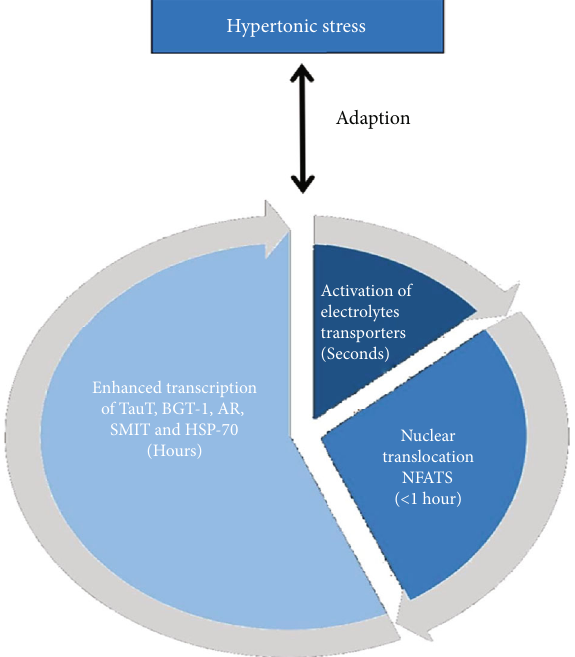
Figure 2: Cell adaption to hypertonic stress. Nuclear factor of activated T cells (NFAT) 5, taurine transporter (TauT),